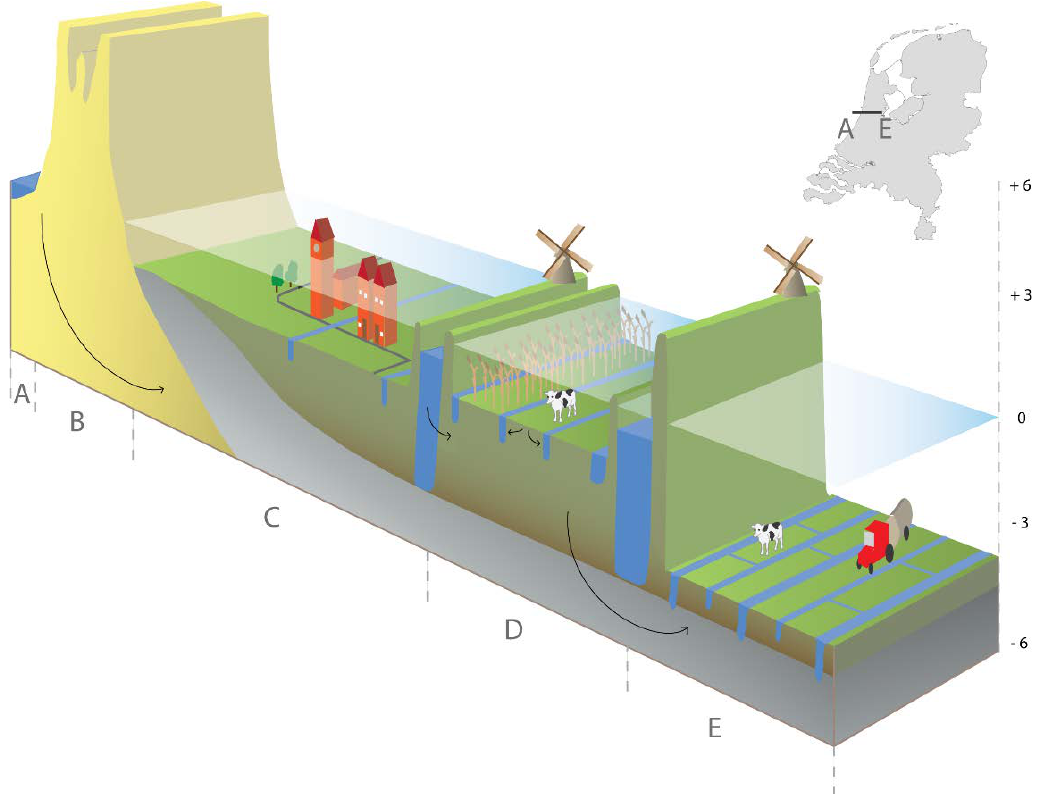
Figure 1. Schematic representation of a typical Dutch peatland area, drained for the purpose of urban and agricultural use, located several metres below seawater level. A) Sea level; B) Sand dunes, dikes and levees to prevent flooding; C) drained urban area; D) drained peatland predominantly used for agriculture, also called ‘peat meadow’ in The Netherlands. Small parts of these peatlands still comprise more natural marshes; E) drained polder with clay soil, where the peat soil has disappeared or almost disappeared due to excavation and peat oxidation (from: van Diggelen 2015, created by Gijs van